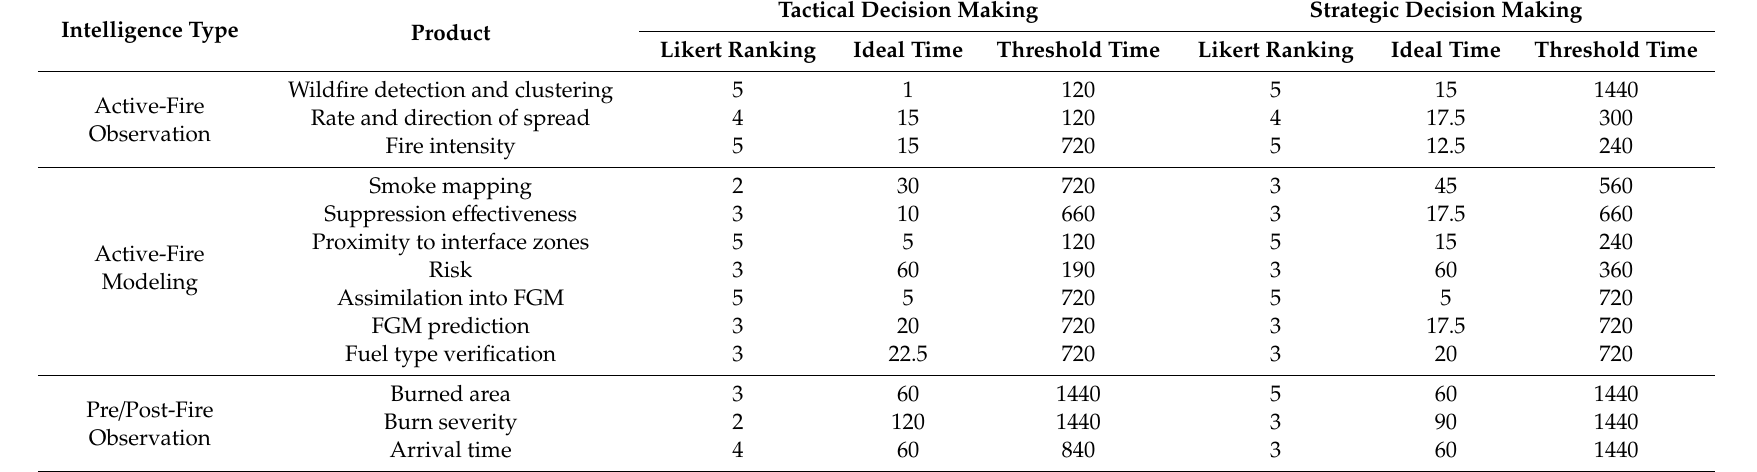
Table 2. Summary of median latency requirements (minutes) for tactical and strategic decision making. FGM refers Fire Growth Modeling. Ideal and threshold times reflect the median desired data latency and the time at the data was considered no longer valuable for the intended purpose. Likert scoring (1–5; unimportant to very important) is presented as the mode value of the respondent